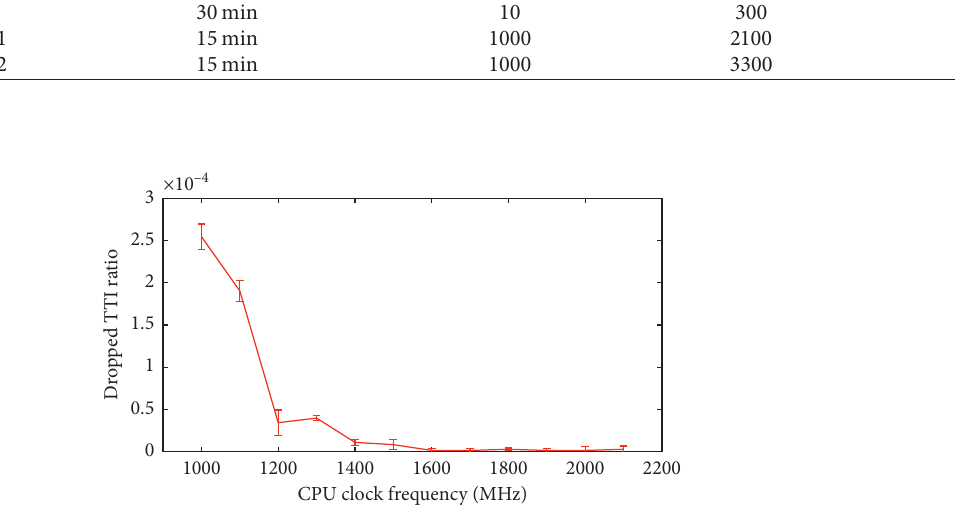
Figure 4: System 1: dropped TTI ratio for each clock frequency value recorded. The red line is the median with the vertical bars depicting ± one standard deviation. 5MHz bandwidth.